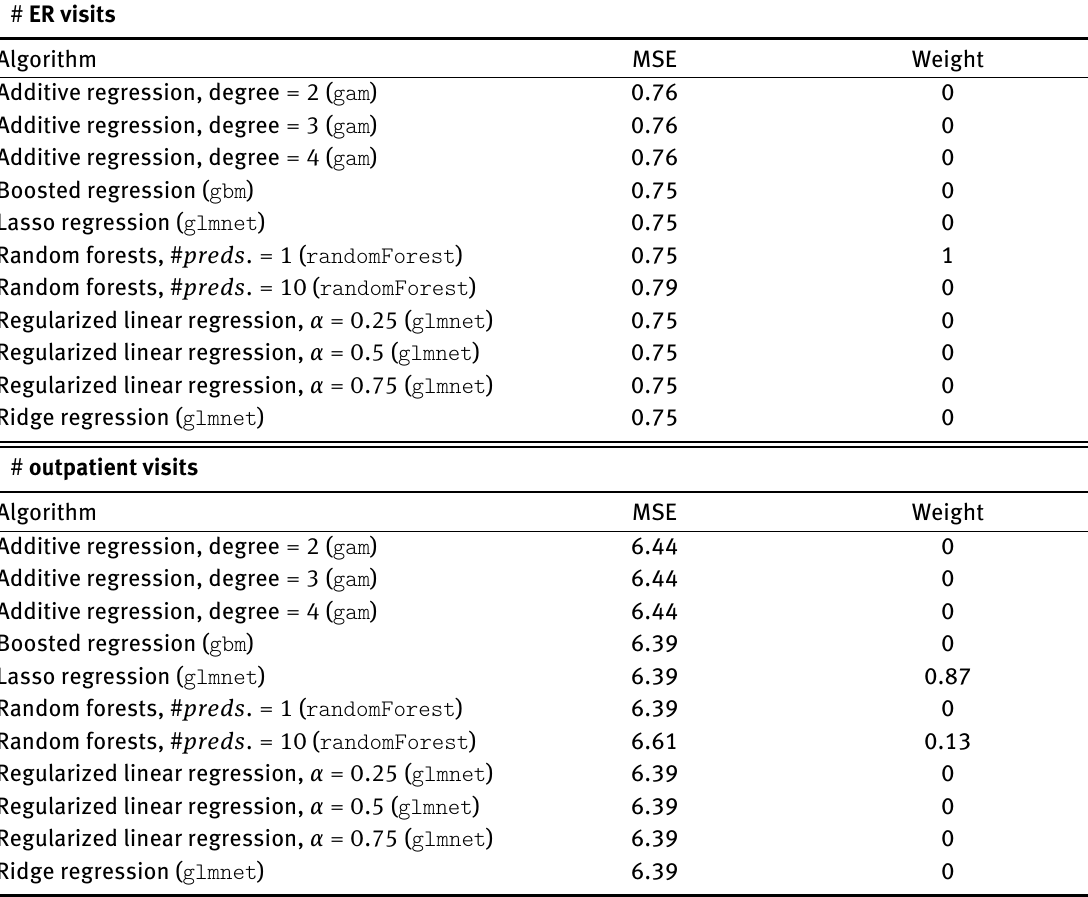
Table B6: Error and weights for candidate algorithms in response ensemble for all RCT